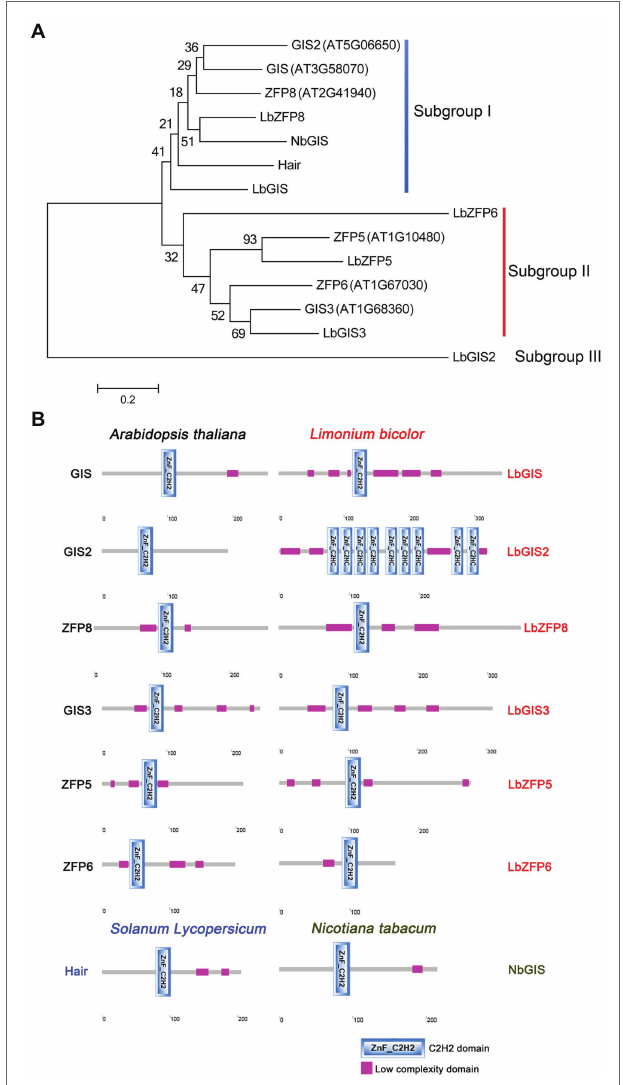
FIGURE 3 | Phylogenetic tree (A) and protein domain analysis (B) of the C2H2 homologous proteins related to trichomes and salt gland development in Arabidopsis, tabacco, tomato, and